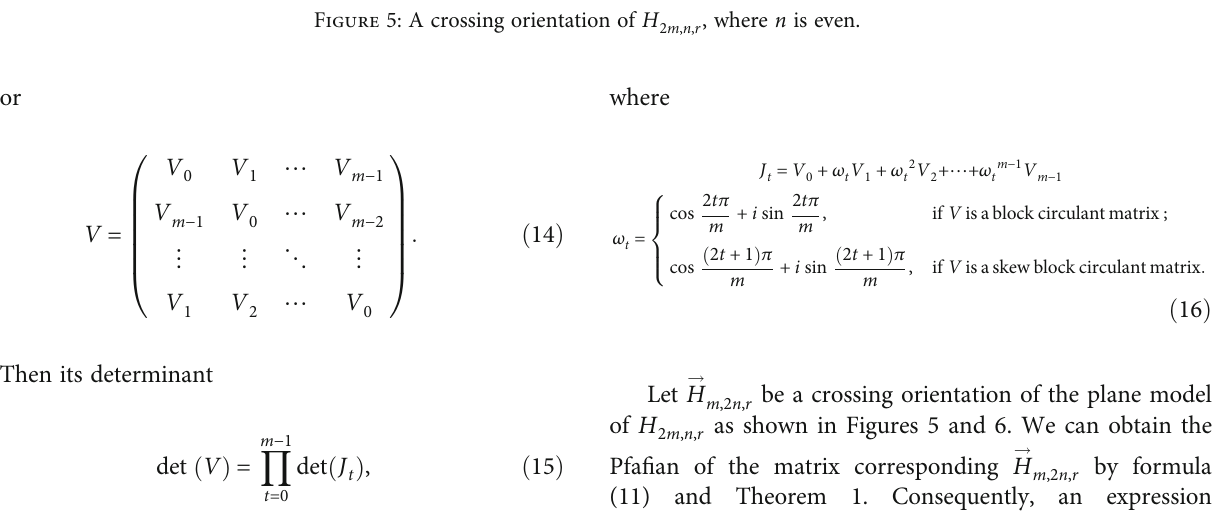
Figure 5: A crossing orientation of H